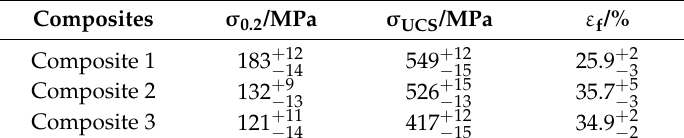
Table 2. Compression properties of the different composites.